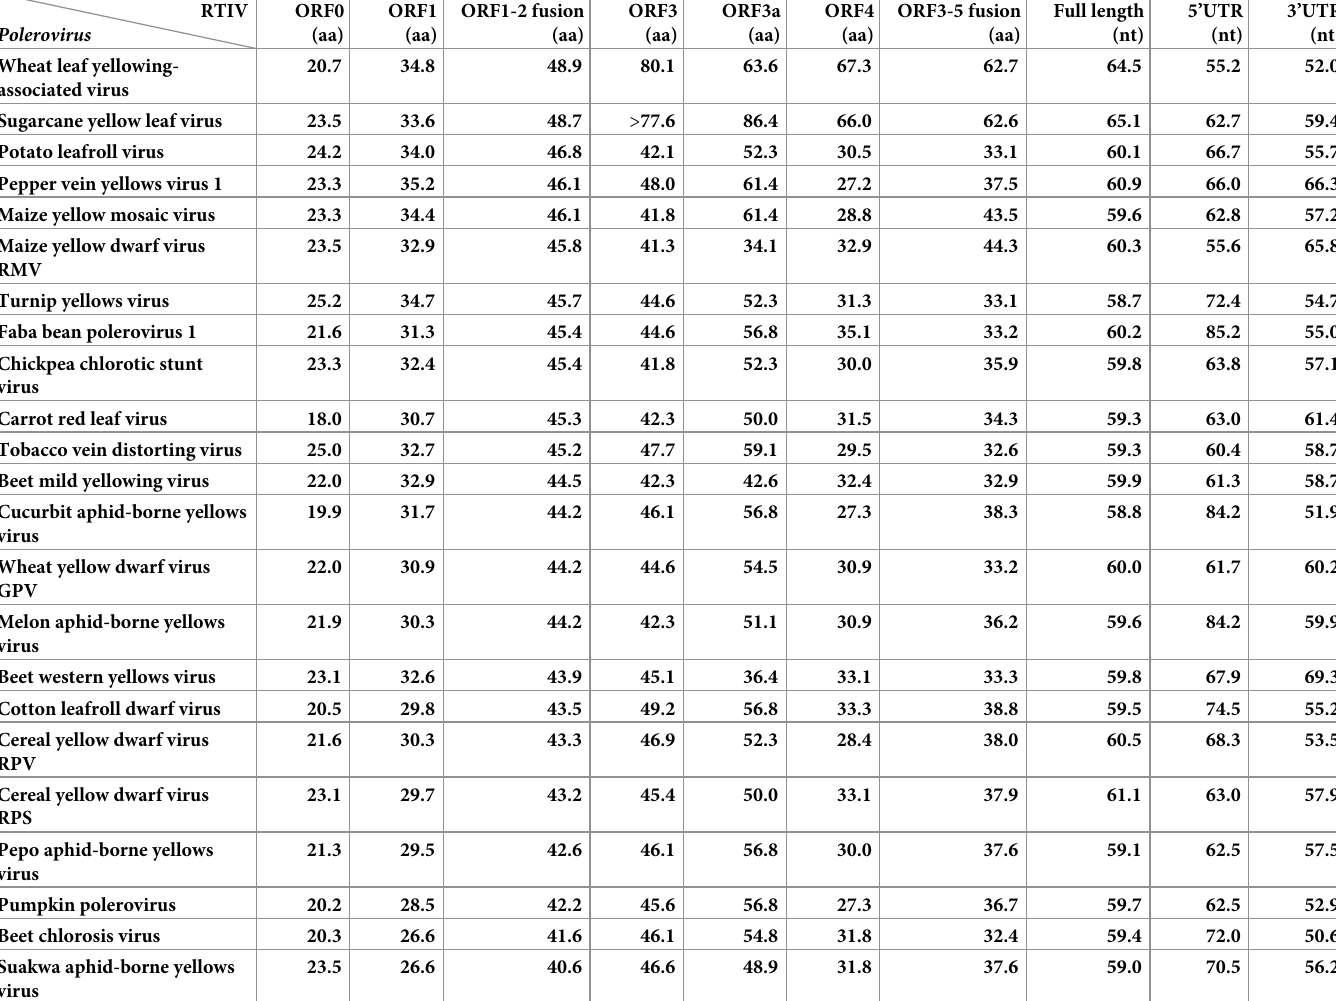
Table 1. Identity percentage of viral proteins and nucleotide sequences of RTIV with known members in Polerovirus. Identity percentage of amino acid and nucleo- tide was analyzed by Sequence Demarcation Tool. Accession number of known poleroviruses used in the analysis was listed in S2 Table. RTIV ORF0 (aa) Polerovirus Wheat leaf yellowing- associated virus